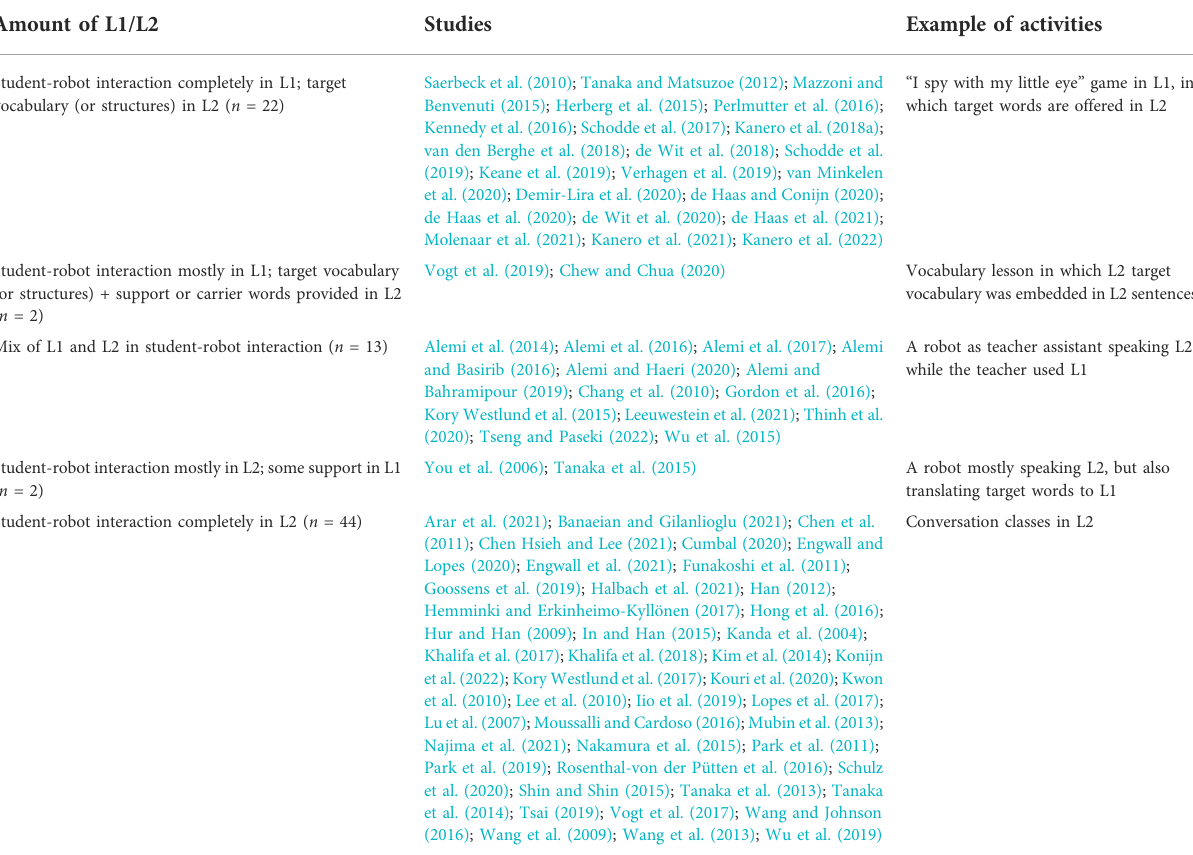
TABLE 1 Overview of usage of L1 and L2 in RALL